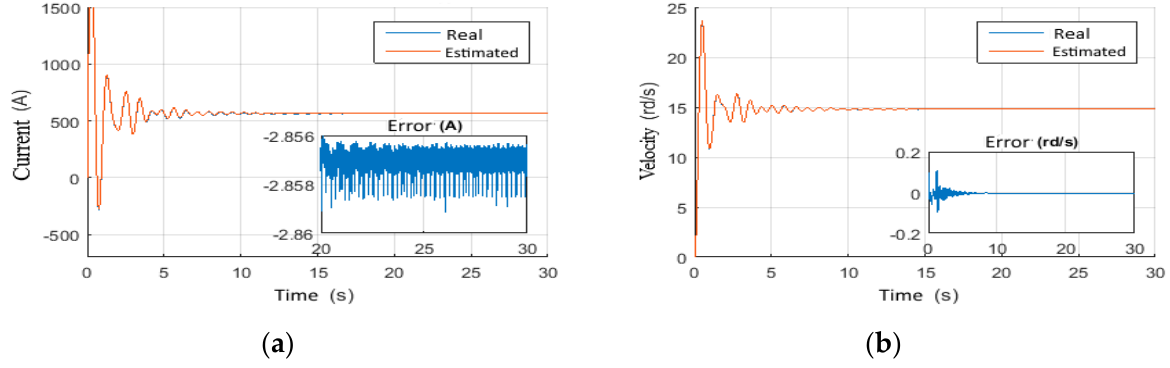
Figure 22. Measured and estimated variables by the designed Observer for Scenario-5: ( a ) Top-drive current, ( b ) Velocity.